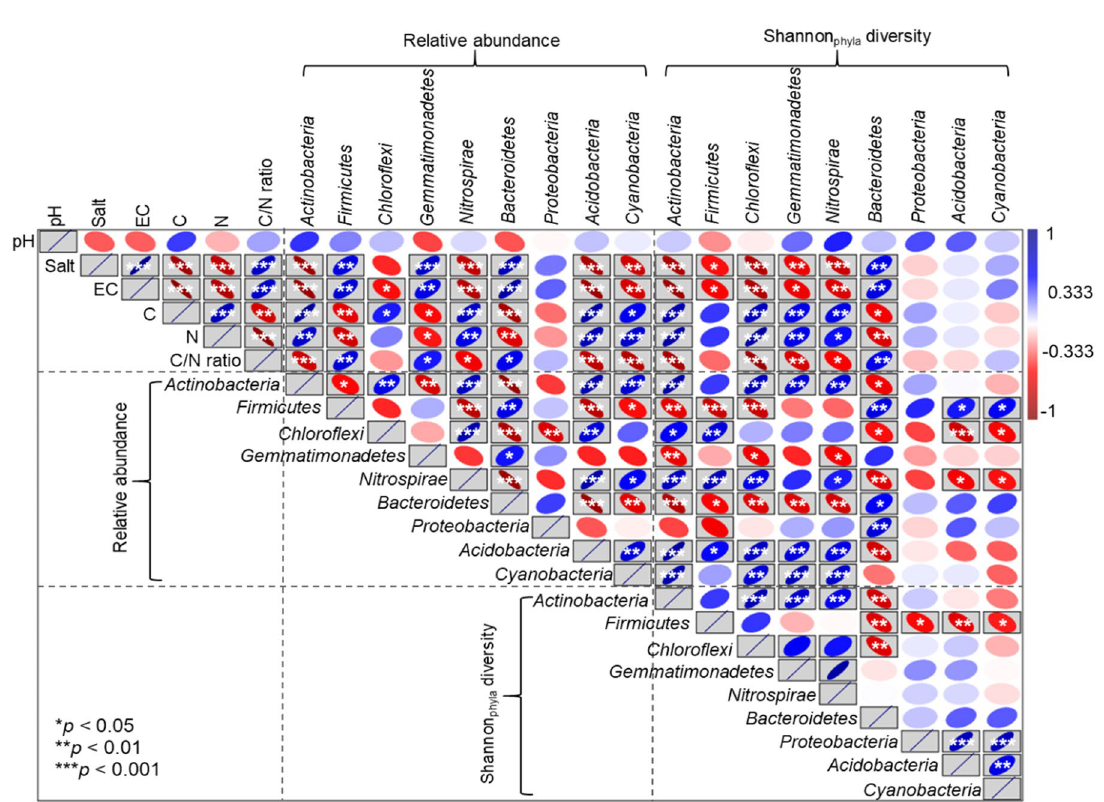
Figure 4. Spearman correlation analyses between soil physiochemical properties and the relative abundances and Shannon diversity of soil bacterial phyla. EC: electrical conductivity, TC: total carbon, TN: total nitrogen, and C/N ratio: soil total carbon/nitrogen. *, **, and *** indicate significance along the paths at p < 0.05, p < 0.01, and p < 0.001 levels,